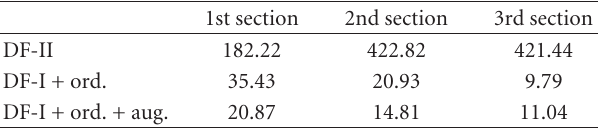
Table 1: Maximum absolute signal range in di ff erent sections of a low-pass filter implemented with di ff erent